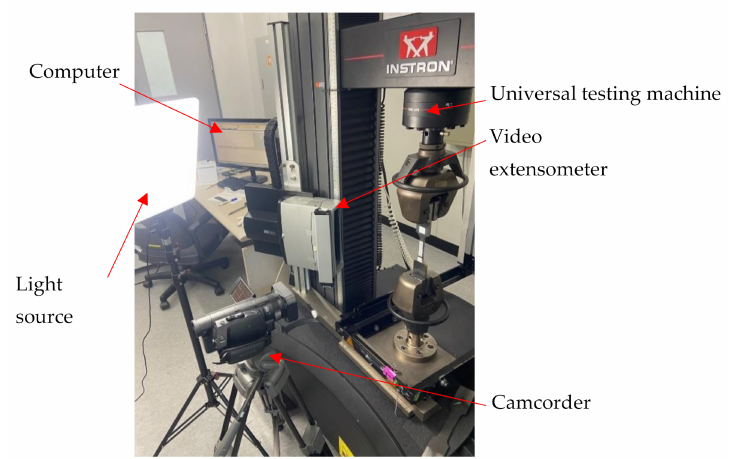
Figure 2. Testing set-up for fracture